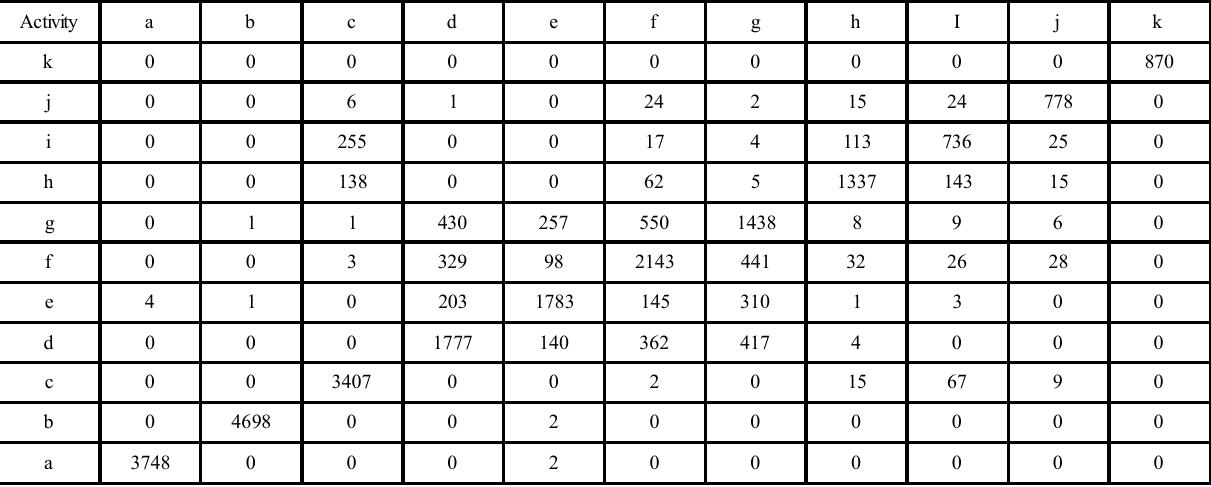
TABLE 2. 11 ACTIVITIES’ CONFUSION MATRIX USING J48 ALGORITHM